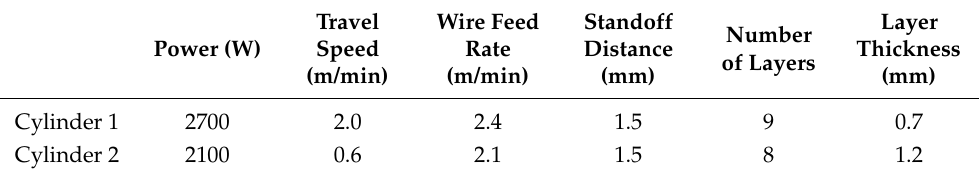
Table 1. Process parameters for the two deposited cylinders.